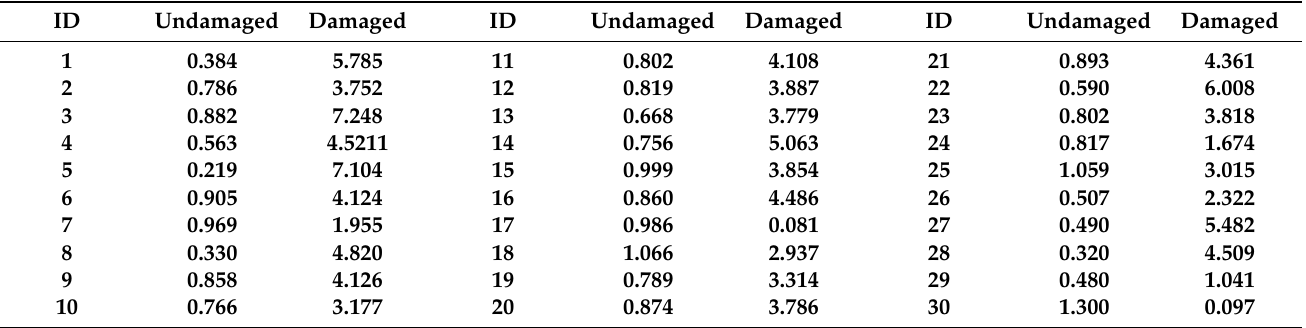
Table 1. Mean anomaly scores of undamaged and damaged data. ID column represents the code of the accelerometer; the Undamaged column represents the average anomaly score of the undamaged data; and the Damaged column represents the anomaly score of the damaged